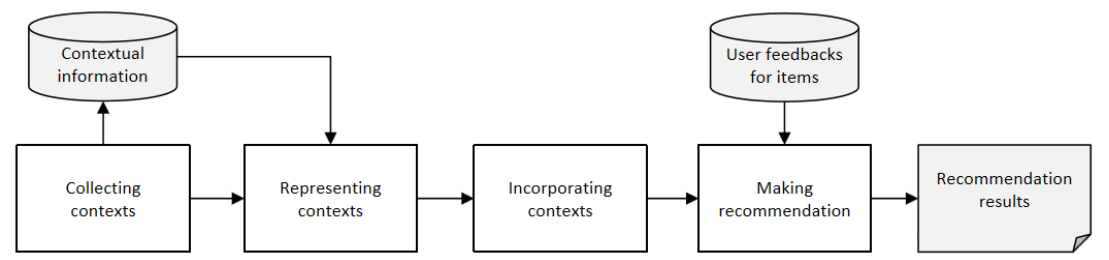
Figure 2. Process of context-aware recommendation in